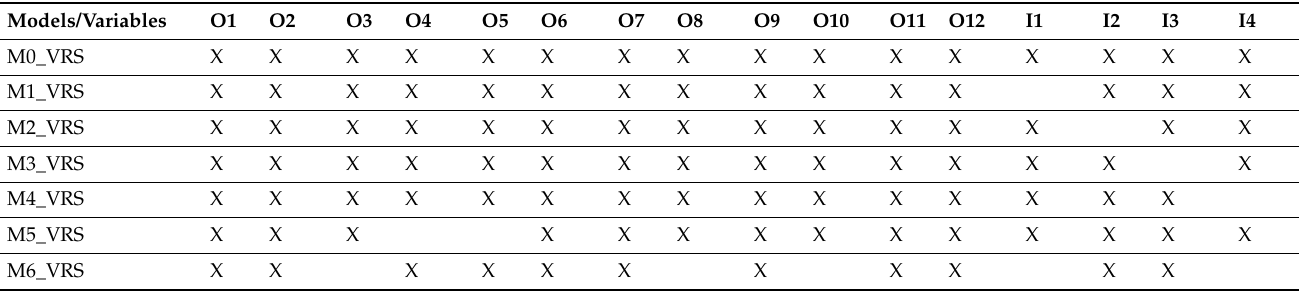
Table 9. Different models for internal validity